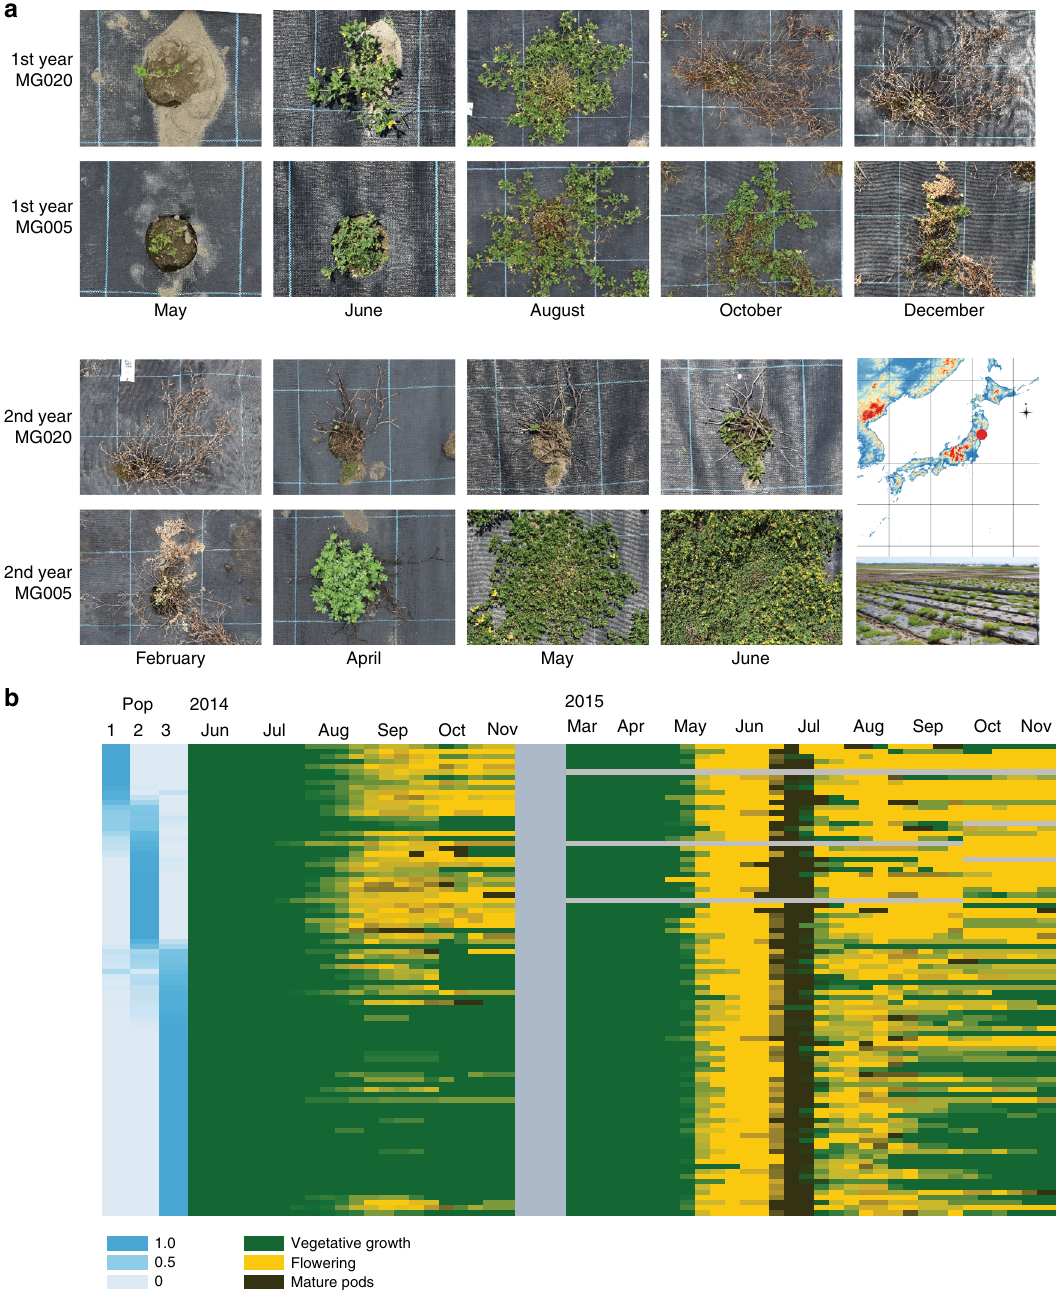
Fig. 3 Overwintering and fl owering time phenotypes. a Pictures from the fi eld site at Tohoku, 38.46 N, 141.09 E, 2017/2018. MG020 is from Miyako Island in the southernmost part of Japan, whereas MG005 is a winter-hardy accession from central Japan near Tokyo. 1st year is the year the seedlings were transplanted to the fi eld site. b Flowering time summary for the 2014/2015 season. Gray color indicates no available data. Flowering proportion 2014 (FP 2014) was quanti fi ed as number of individuals fl owering in 2014 divided by the total number of established plants. The end of fl owering 2015 was quanti fi ed as the number weeks fl owers were observed after senescence of the fi rst set of pods. The fi rst set of pods senesced in July 2015 for most